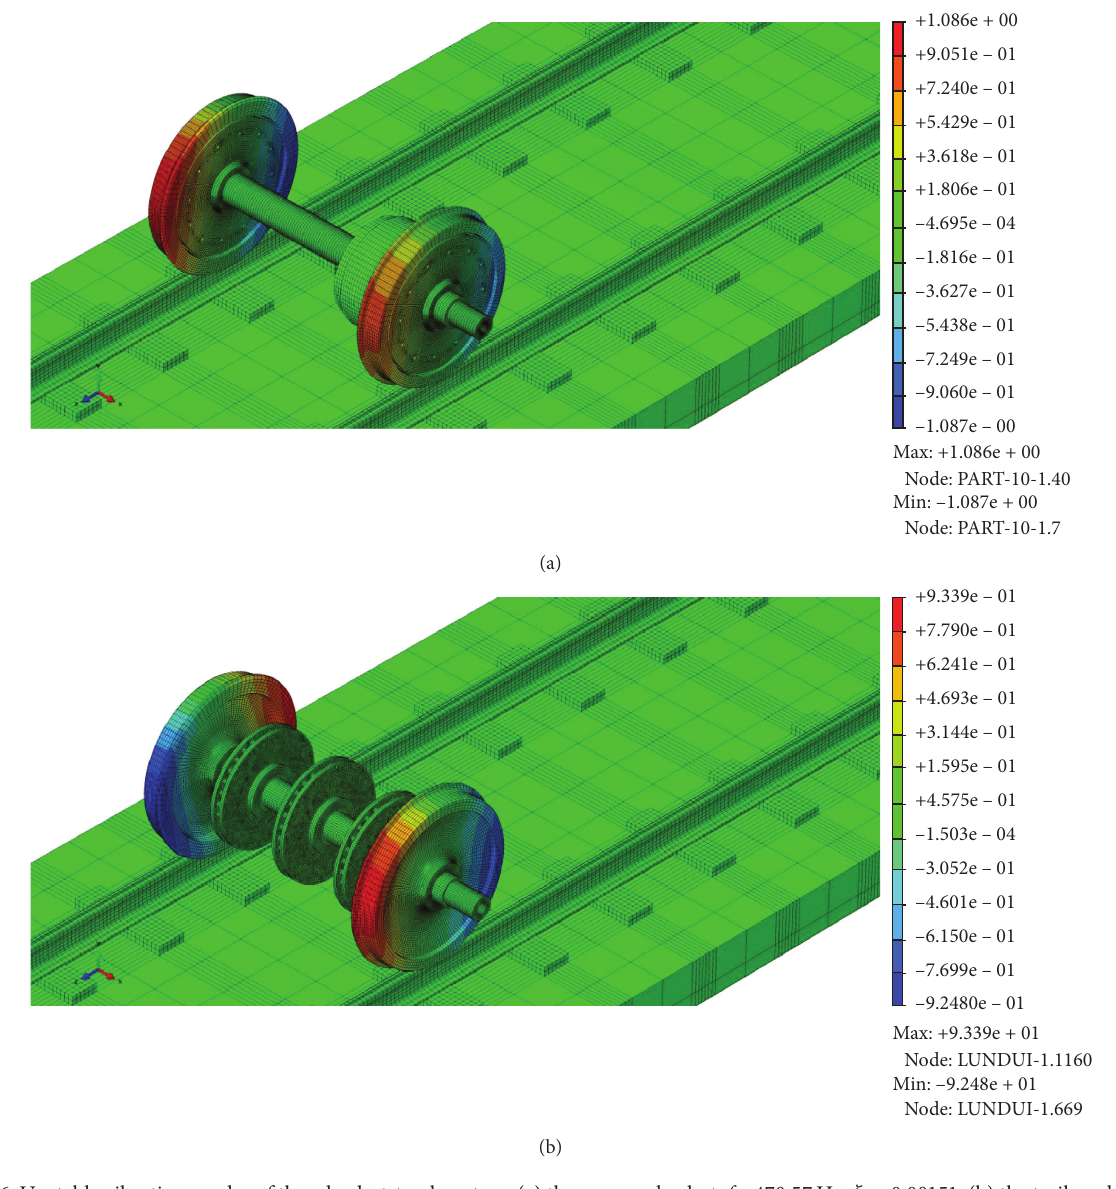
Figure 6: Unstable vibration modes of the wheelset-track system: (a) the power wheelset, f � 470.57Hz, ξ � -0.00151, (b) the trailer wheelset, f � 490.55Hz, ξ � -0.00135.